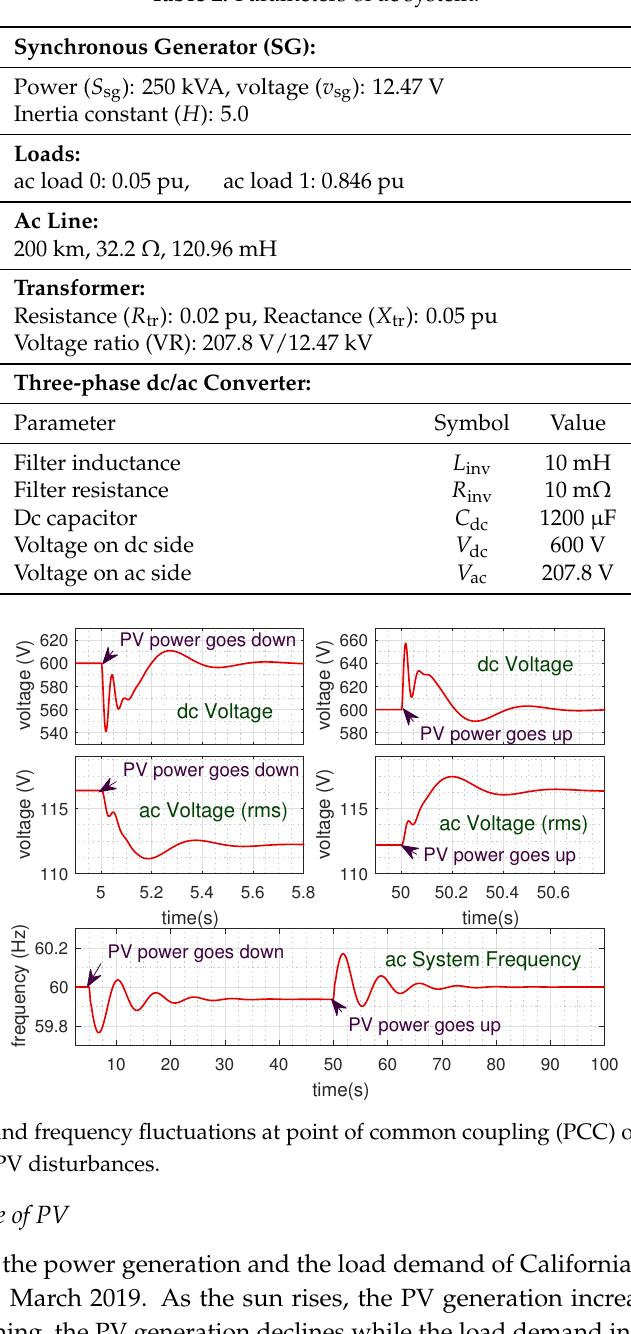
Table 2. Parameters of ac system.